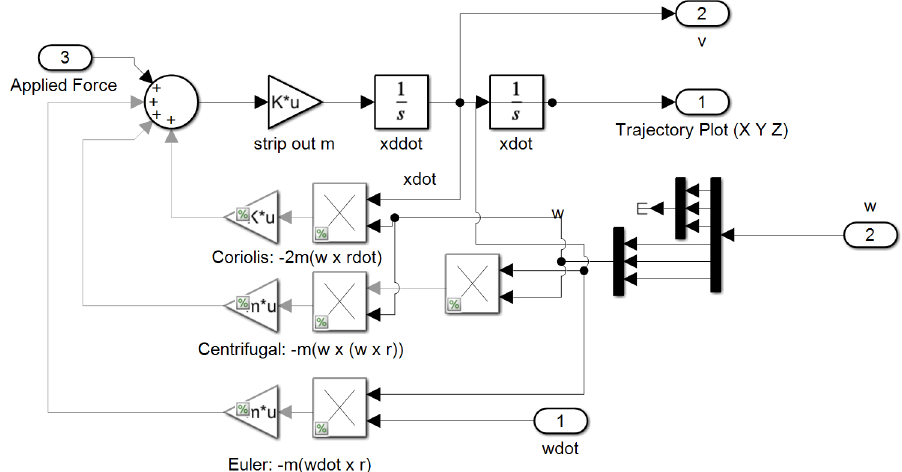
Figure A5. Translation subsystem in Figure A1.